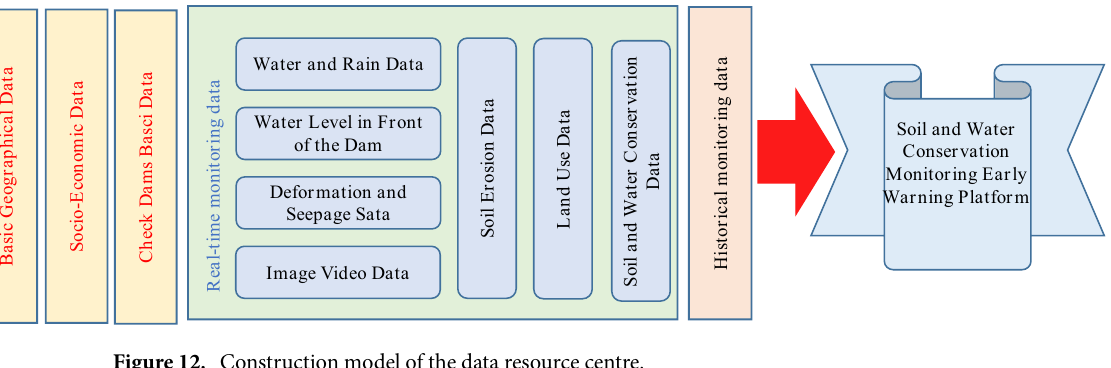
Figure 12. Construction model of the data resource